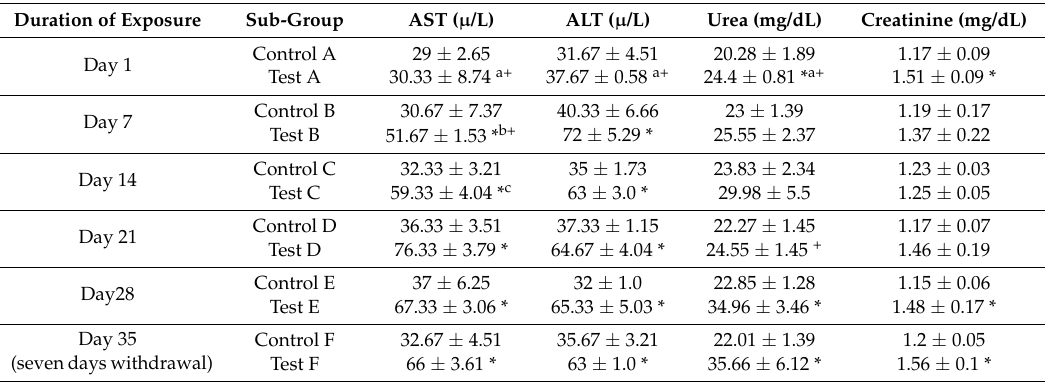
Table 3. Mean biochemical indices as compared to